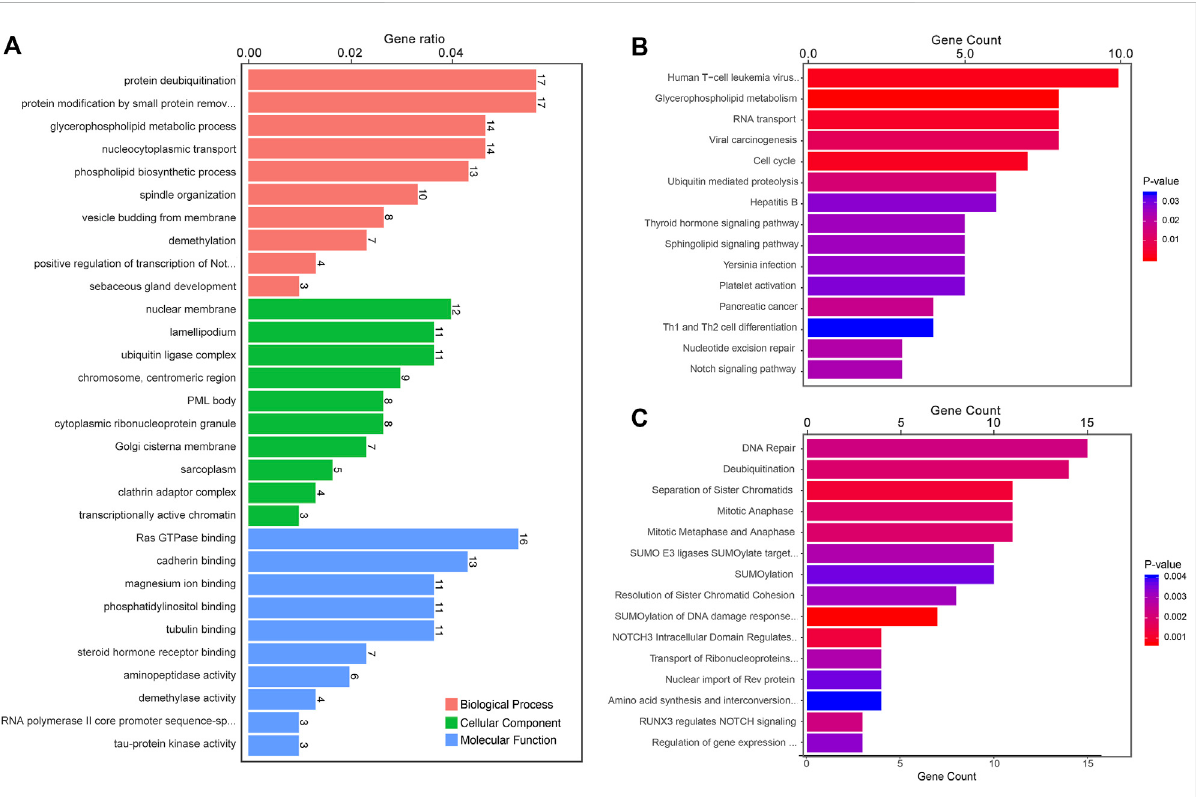
FIGURE 4 Functional predictions of differentially expressed circRNAs between LUAD-BM and healthy individuals. (A) Top 10 GO analysis to demonstrate themolecularfunctionsofdysregulatedcircRNAs. (B) Top15signi fi cantenrichmentKEGGpathwaysofdysregulatedcircRNAs. (C) Top15signi fi cant enrichment Reactome pathways of dysregulated circRNAs. LUAD-BM, lung adenocarcinoma with bone